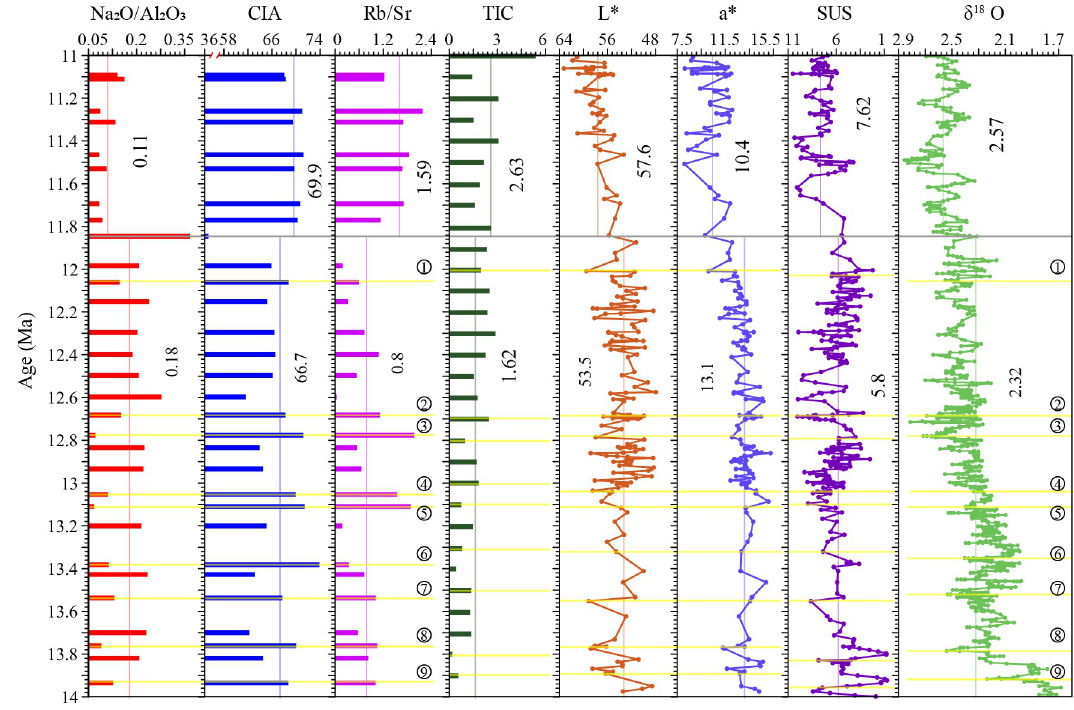
Fig 5. Comparison of variations in Na 2 O/Al 2 O 3 , CIA, and Rb/Sr for the Sikouzi fluviolacustrine sediments with variations in L � , a � [10] and the integrated benthic δ 18 O record